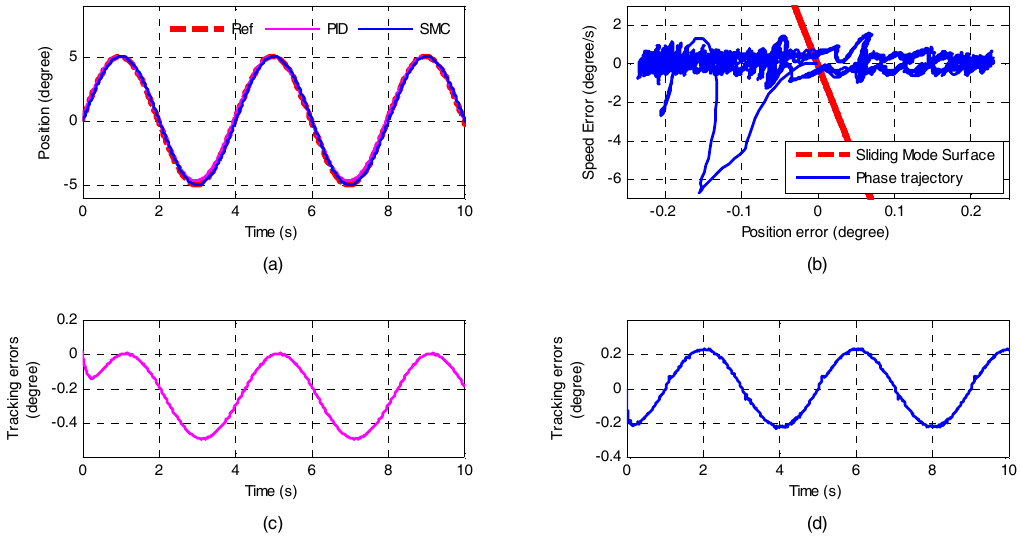
Figure 12. Experiment of sinusoidal response of Joint 1: ( a ) Position tracking; ( b ) Phases trajectory diagram of SMC; ( c ) Tracking error of PID; and ( d ) Tracking error of SMC.